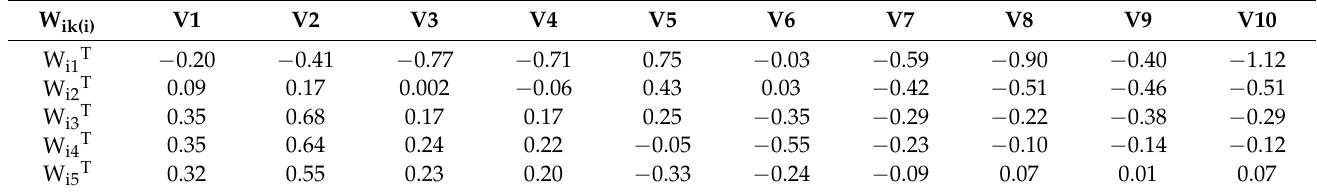
Table 6. Weights assigned to the independent variables in the statistical analyses carried out at